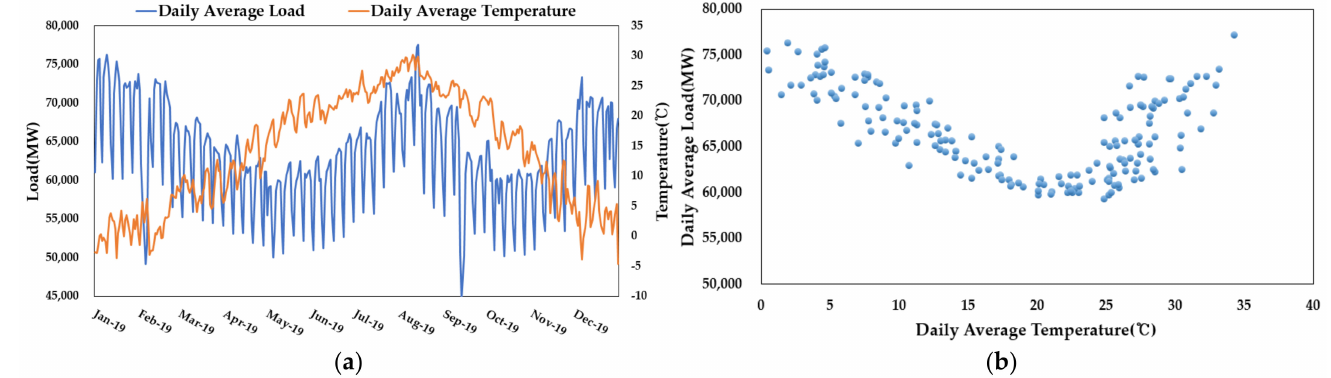
Figure 1. The electric load characteristics according to temperature: ( a ) the daily interval-valued electric load and temperature in 2019; ( b ) the scatter plot of daily temperature and electric load in 2019.